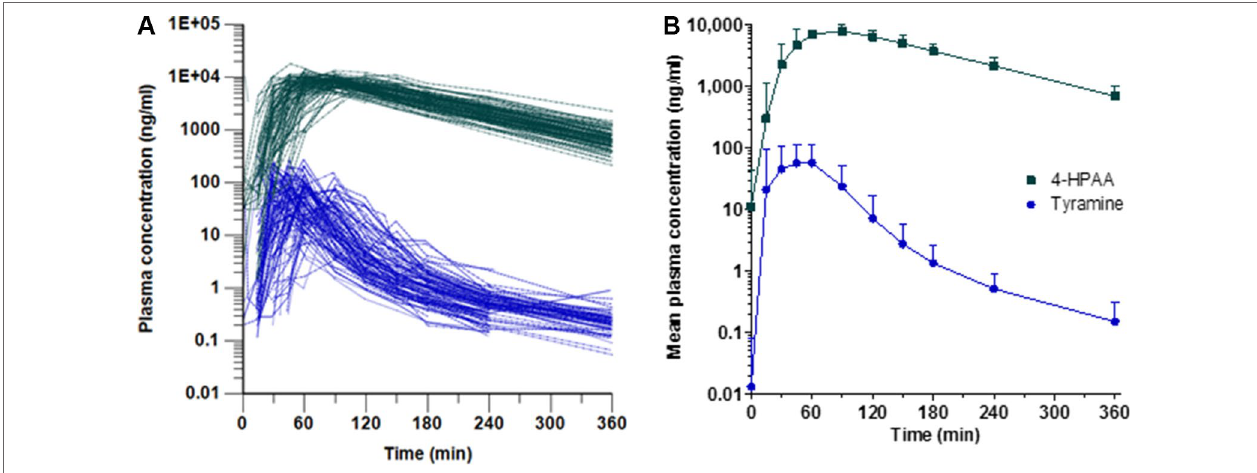
FigUre 2 | Plasma concentrations of tyramine (blue circles) and 4-HPAA (green squares) over time, shown (A) for each participant and (B) as means + SD (n =